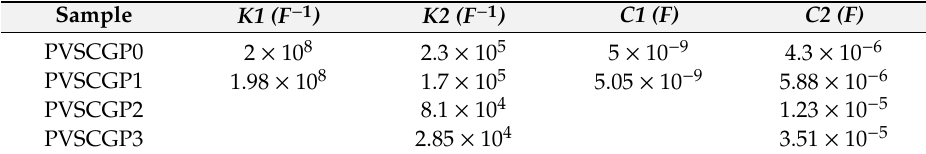
Table 3. The EEC fitting parameters for electrolyte systems at room temperature.